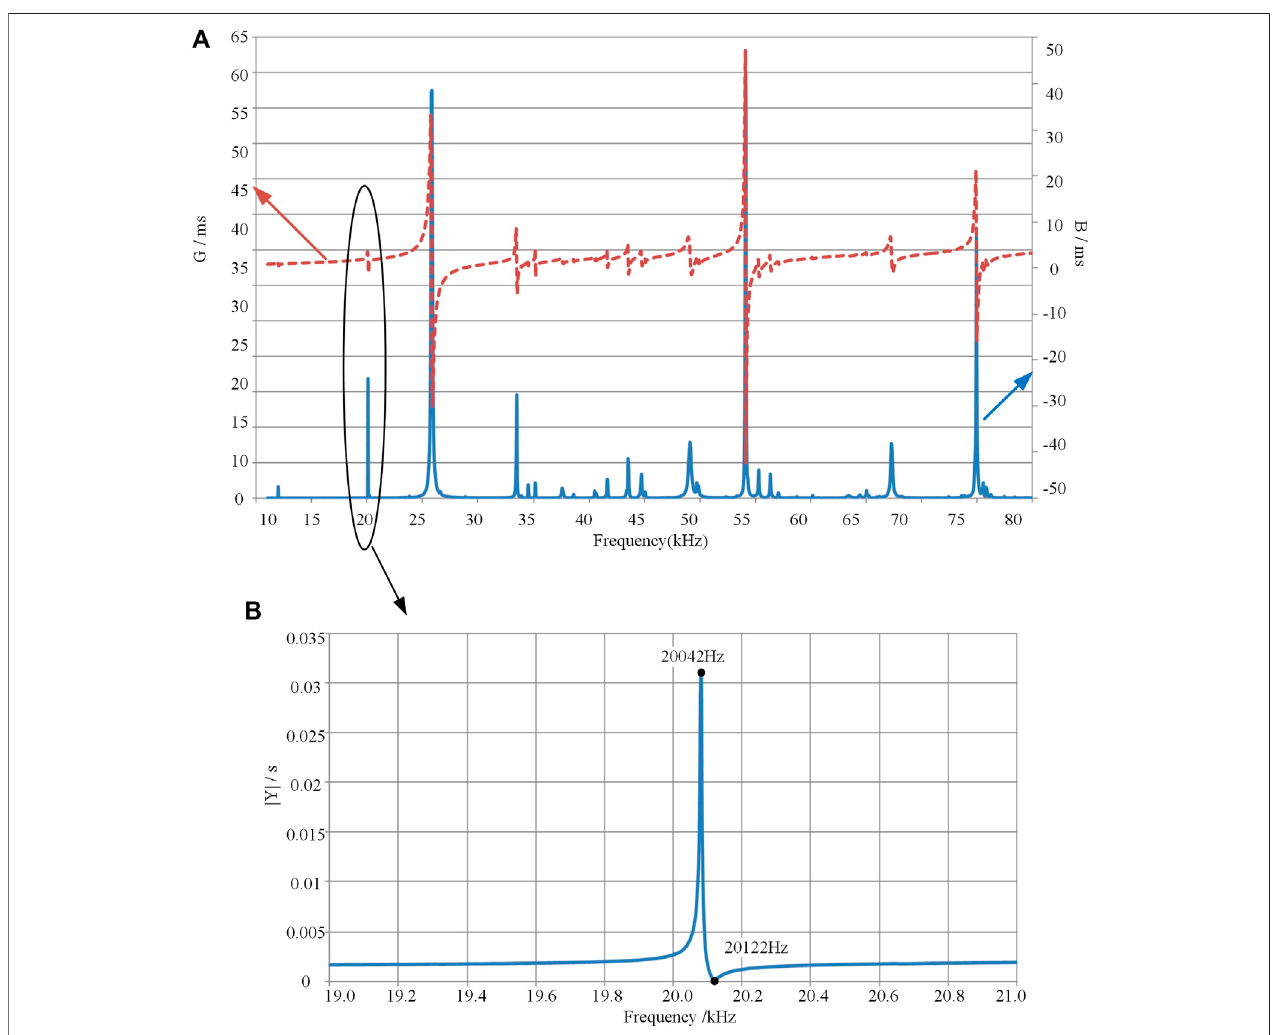
FIGURE 14 | Impedance and phase curve of prototype (A) Impedance curve at full frequency (B) Impedance curve around 20